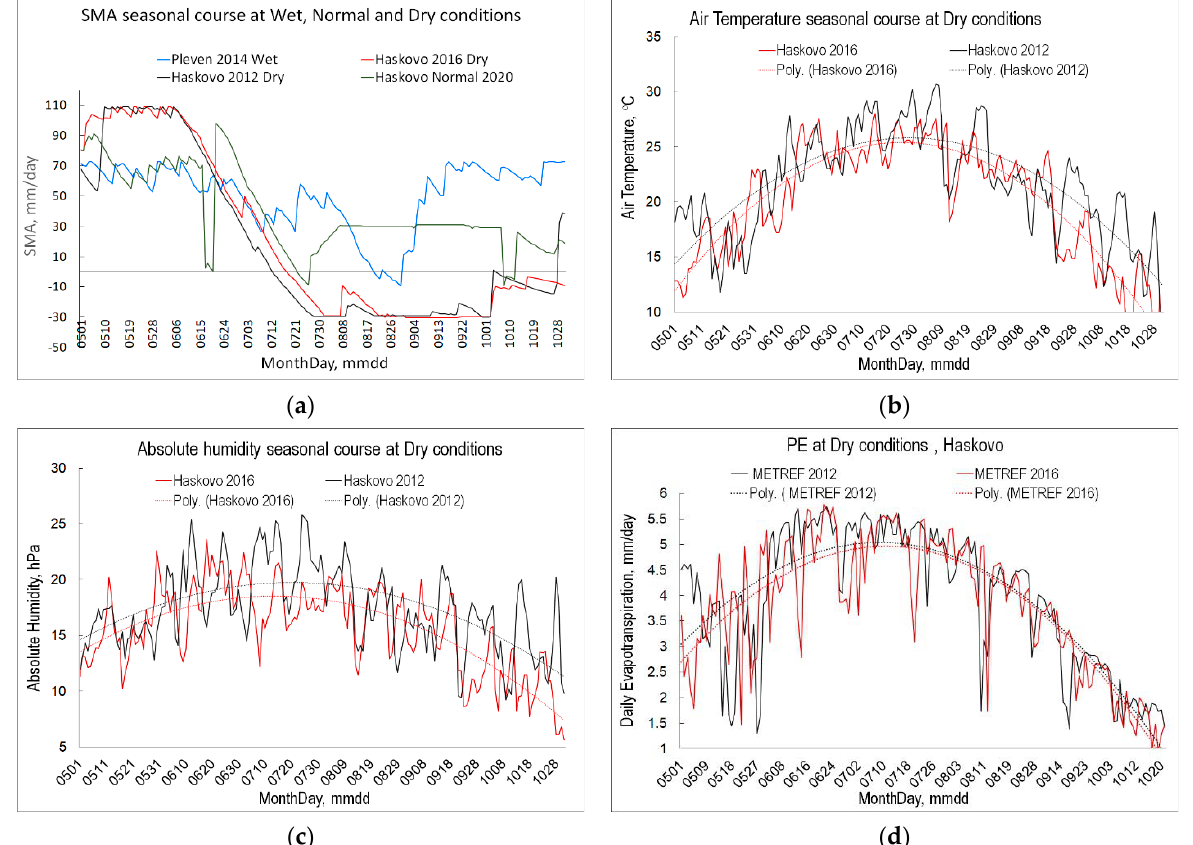
Figure 6. Seasonal (May–October) courses (daily values) of AE (DMET) and PE (METREF) and their trends (described with polynomial functions) under different environmental conditions: ( a ) moist; ( b ) normal; ( c , d ) dry.